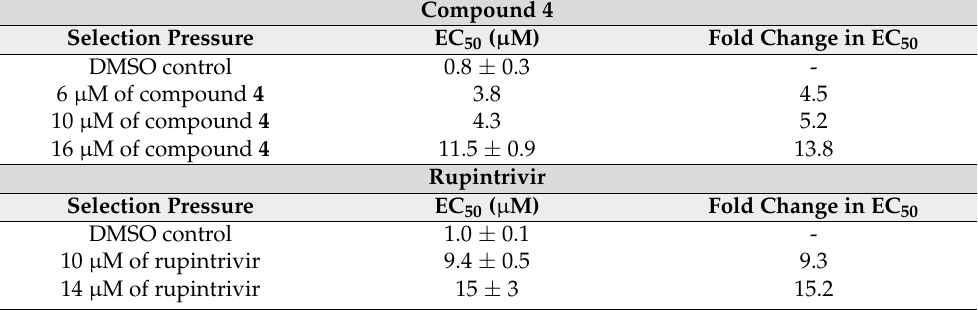
Figure 2. Clearance of the HuNoV GI.1 replicon from HGT cells by compound 4. ( A ) Clearance phase: cells were treated for three consecutive passages with compound 4 (10 µM) without G418. ( B ) Rebound phase: cells from the clearance phase were placed under selective pressure with G418, without compound 4 . The dotted line represents the minimum number of HGT cells required for the next passage. Table 1. Selection of compound 4 and rupintrivir-resistant HuNoV GI.1 replicon